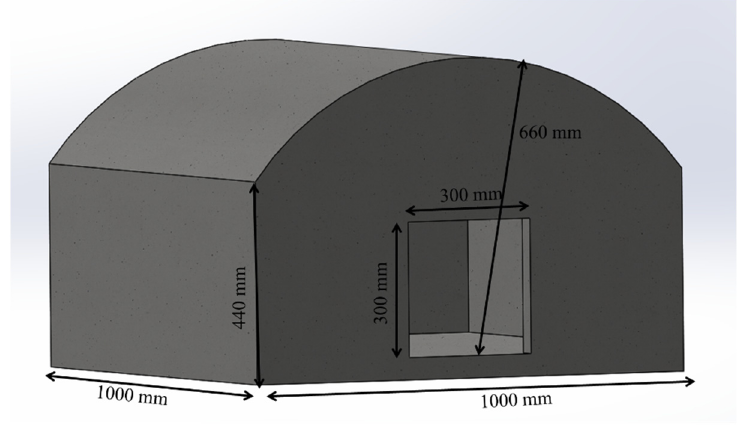
Figure 1. The design details of the structure.